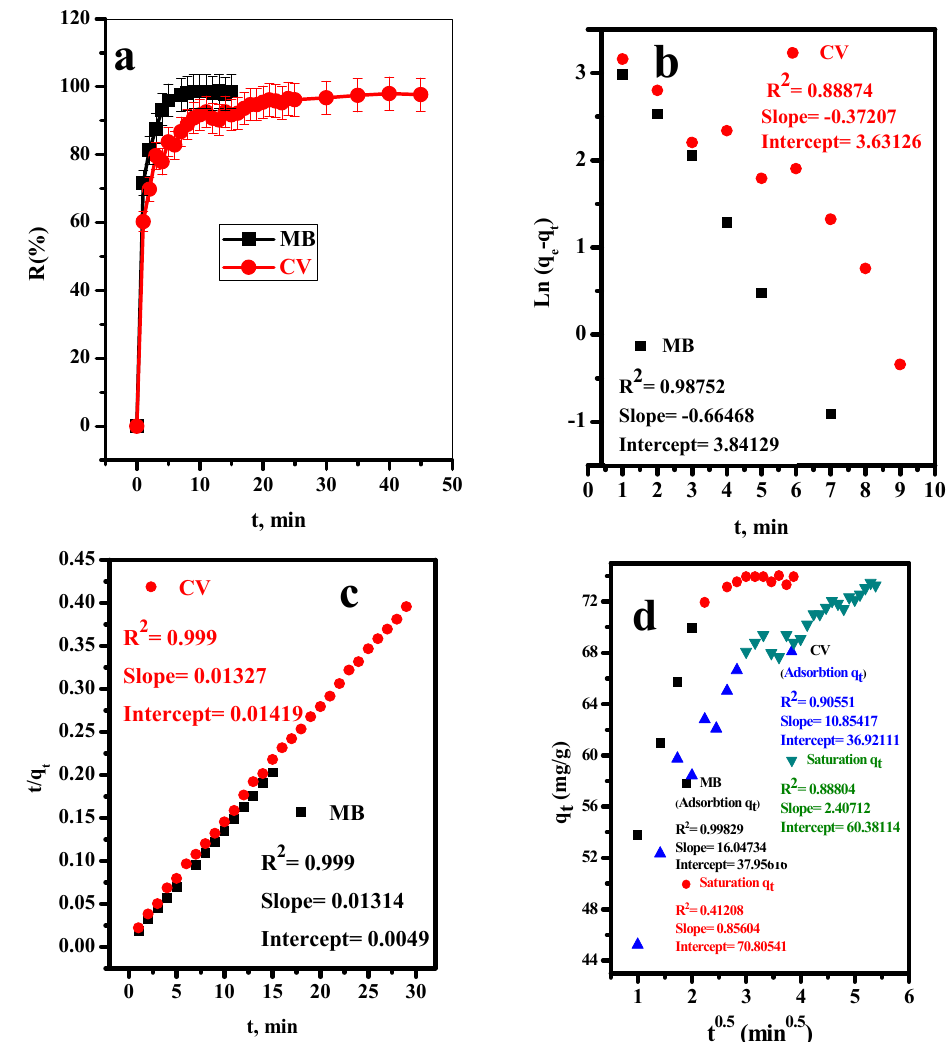
Figure 3. Effect of contact time on ( a ) removal percent, ( b ) pseudo first-order model, ( c ) pseudo second-order kinetic model, and ( d ) intra-partical diffusion models for adsorption of MB and CV-dye onto T-BC adsorbent (t = 15 min for MB and 45 min for CV, (dye) = 30 mg/L, dose = 20 mg, pH = 7, T = 25 °C). Table 2. Adsorption kinetics and diffusion mechanism for removal of MB and CV-dyes.